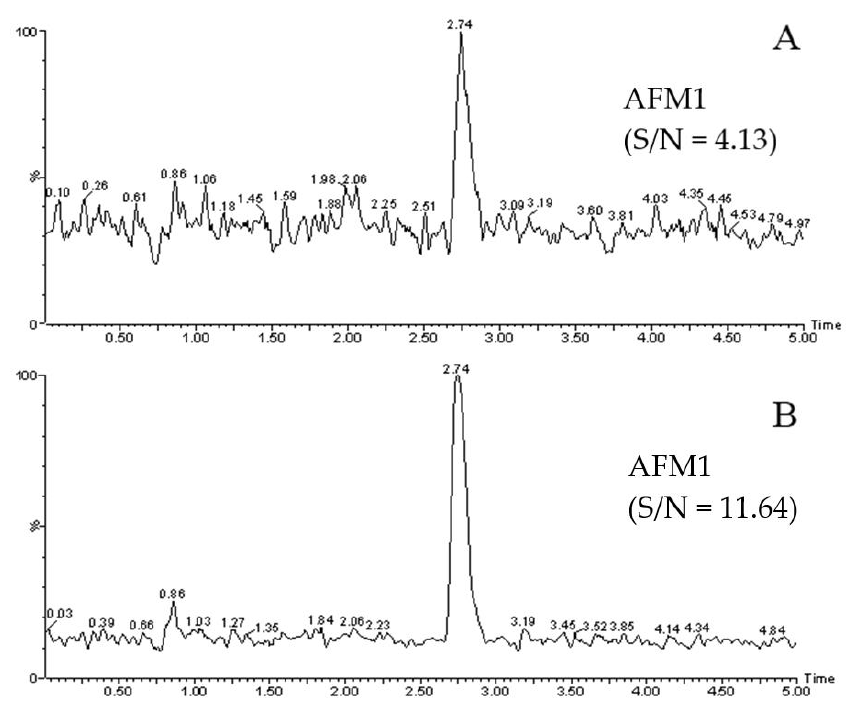
Figure 3. Extracted ion chromatograms of AFM1-spiked milk by the egg white gel method clean-up (( A ) :0.001 μ g/kg, ( B ) :0.01 μ g/kg).